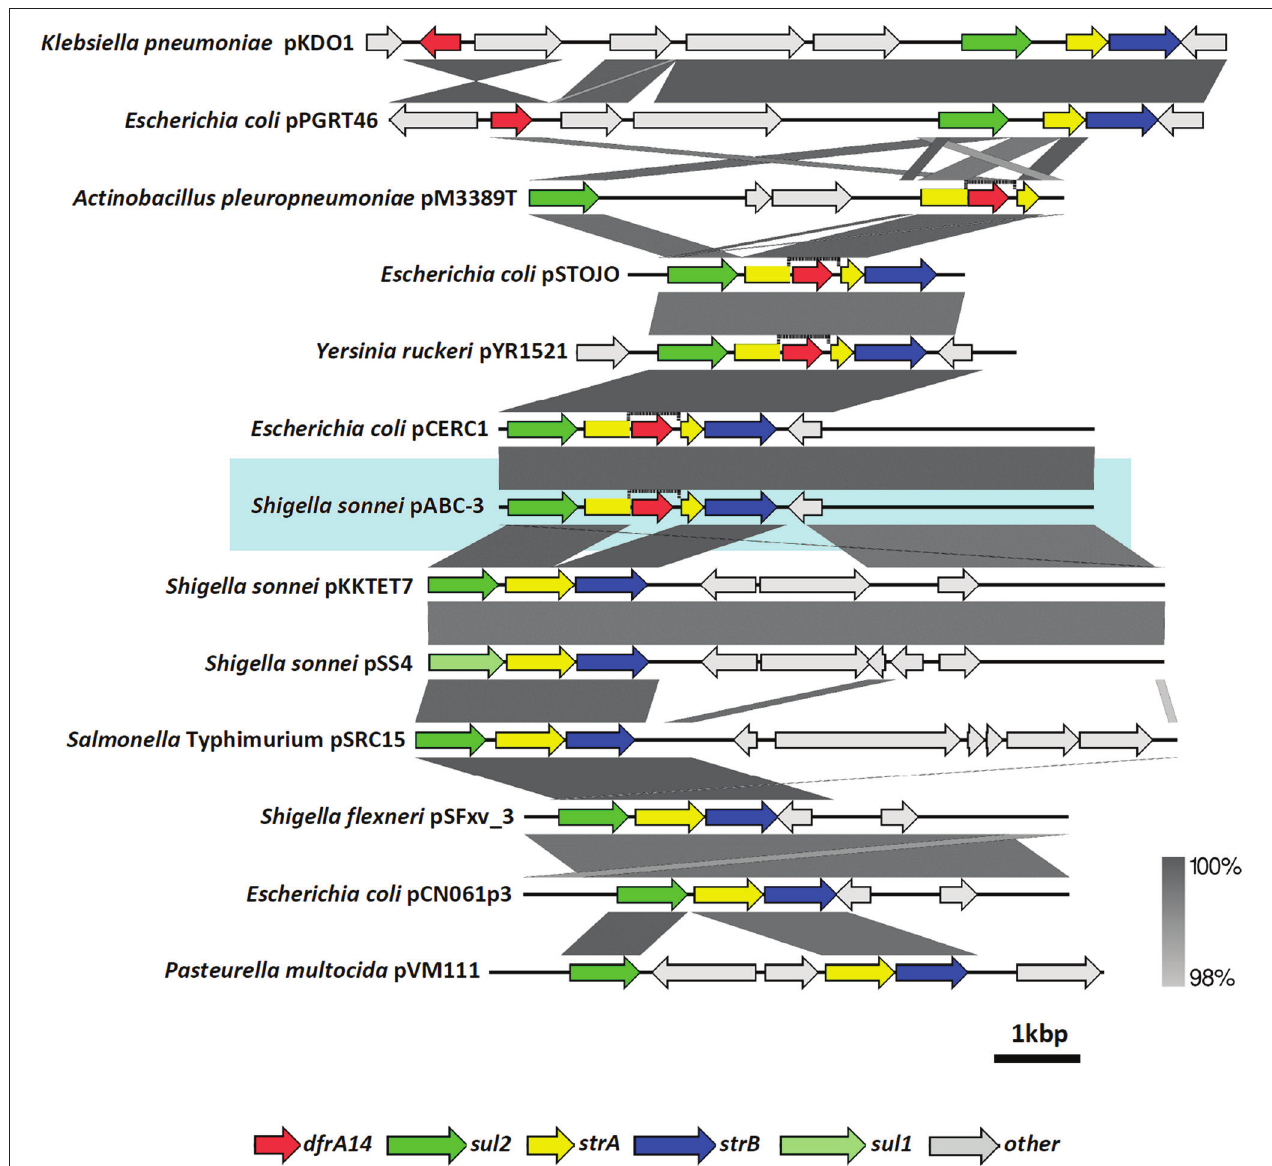
FIGURE 5 | Comparison of different plasmids harboring dfrA14 gene. Alignment of Shigella sonnei pABC-3 with other antibiotic resistance gene clusters contained in plasmids of Gram negative bacteria, which harbor dfrA14 and/or the sul2-strA-strB arrangement. dfrA14 gene is represented by the red arrow. The graphic was built with Easyfig using the blastn algorithm. Vertical bar at the right bottom indicates the threshold of identity percentages in the alignments. More details about plasmids are described in Supplementary